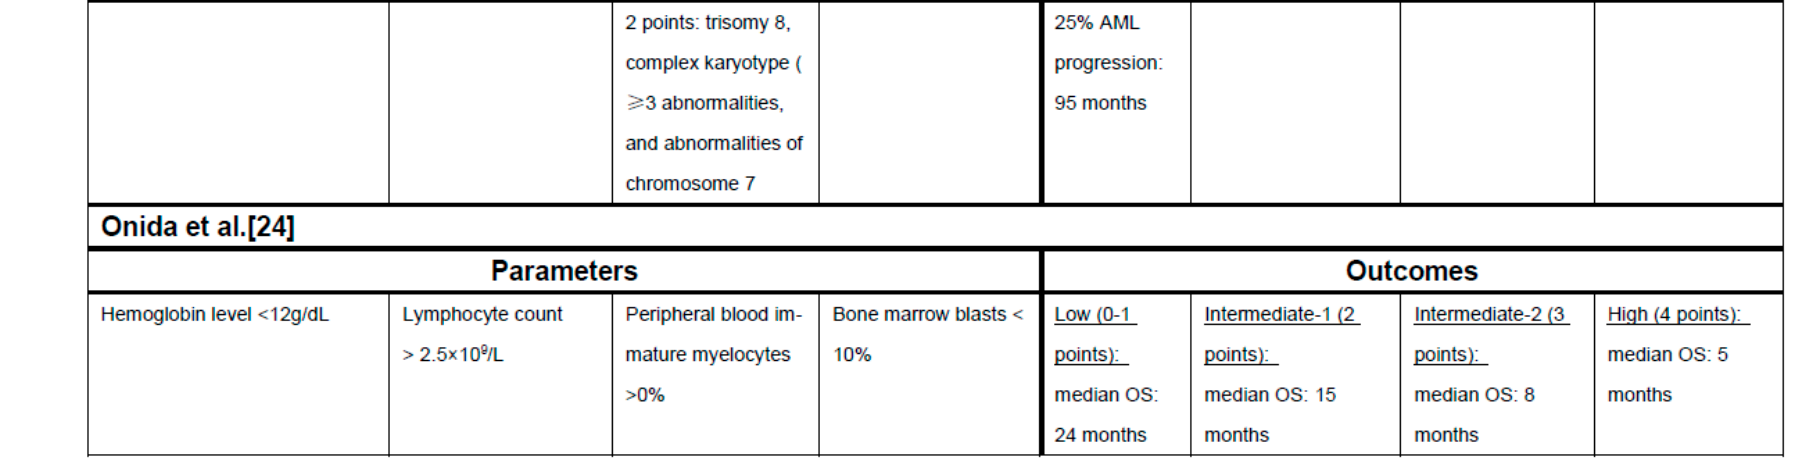
Figure 1. Selected clinical-pathological risk stratification tools for Myelodysplastic syndrome (MDS) and chronic myelomonocytic leukemia (CMML) [4,5,24,25,29]. Underlines: indicate the subheading in each column.